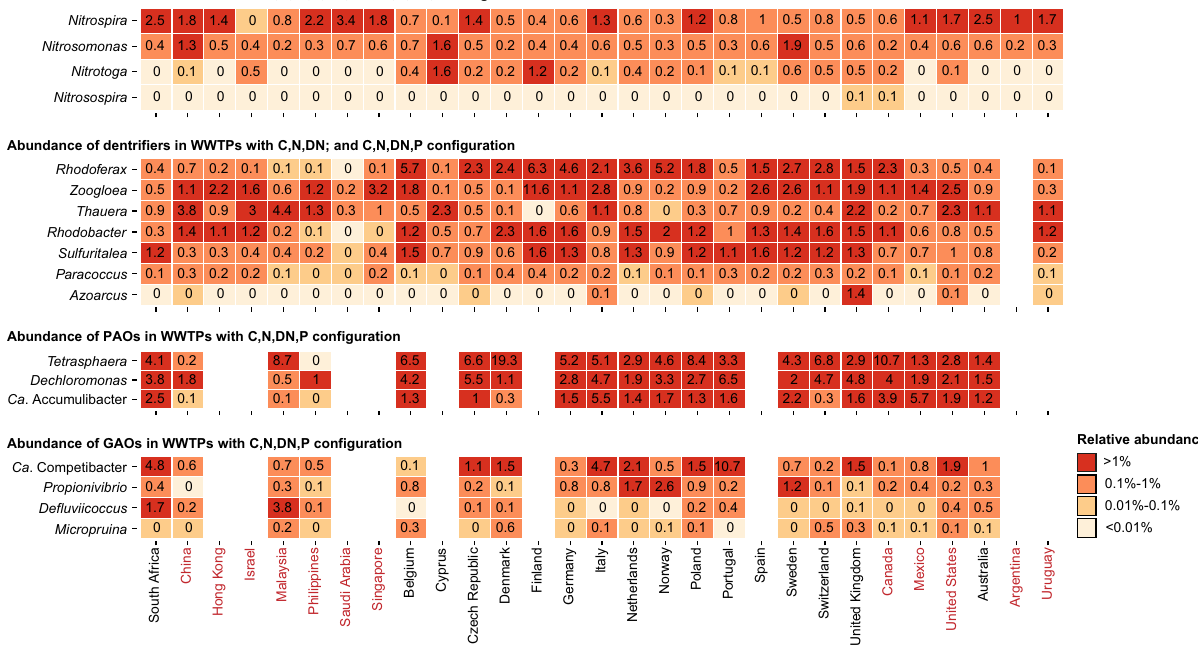
Fig. 8 Global diversity of genera belonging to major functional groups. The percent relative abundance represents the mean abundance for each country considering only WWTPs with the relevant process types. Countries are grouped based on continent (shifting